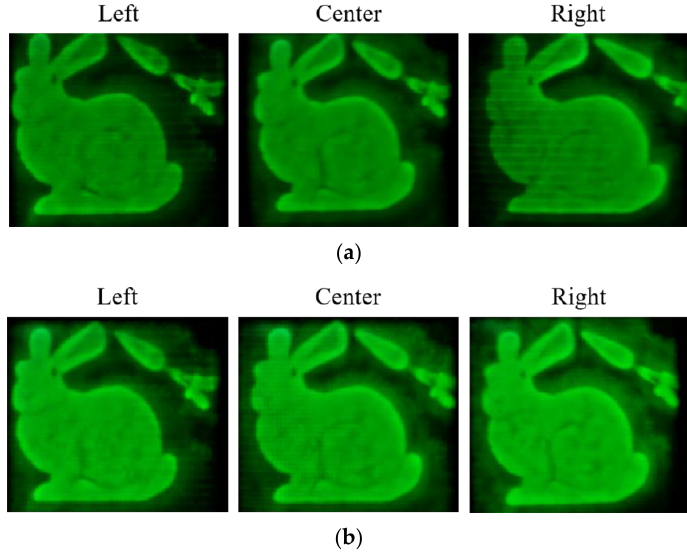
Figure 12. Optical reconstruction of the second object “Bunny and carrot”: ( a ) conventional method and ( b ) proposed method.